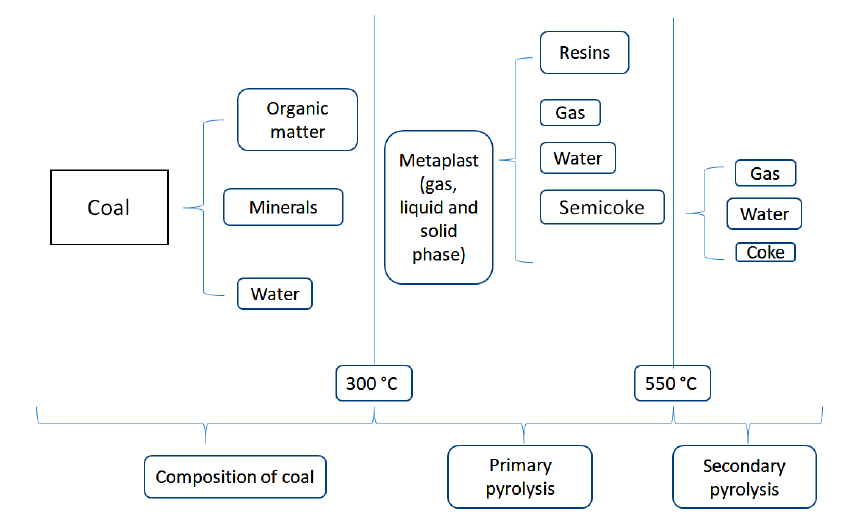
Fig. 2. Pyrolysis of coal